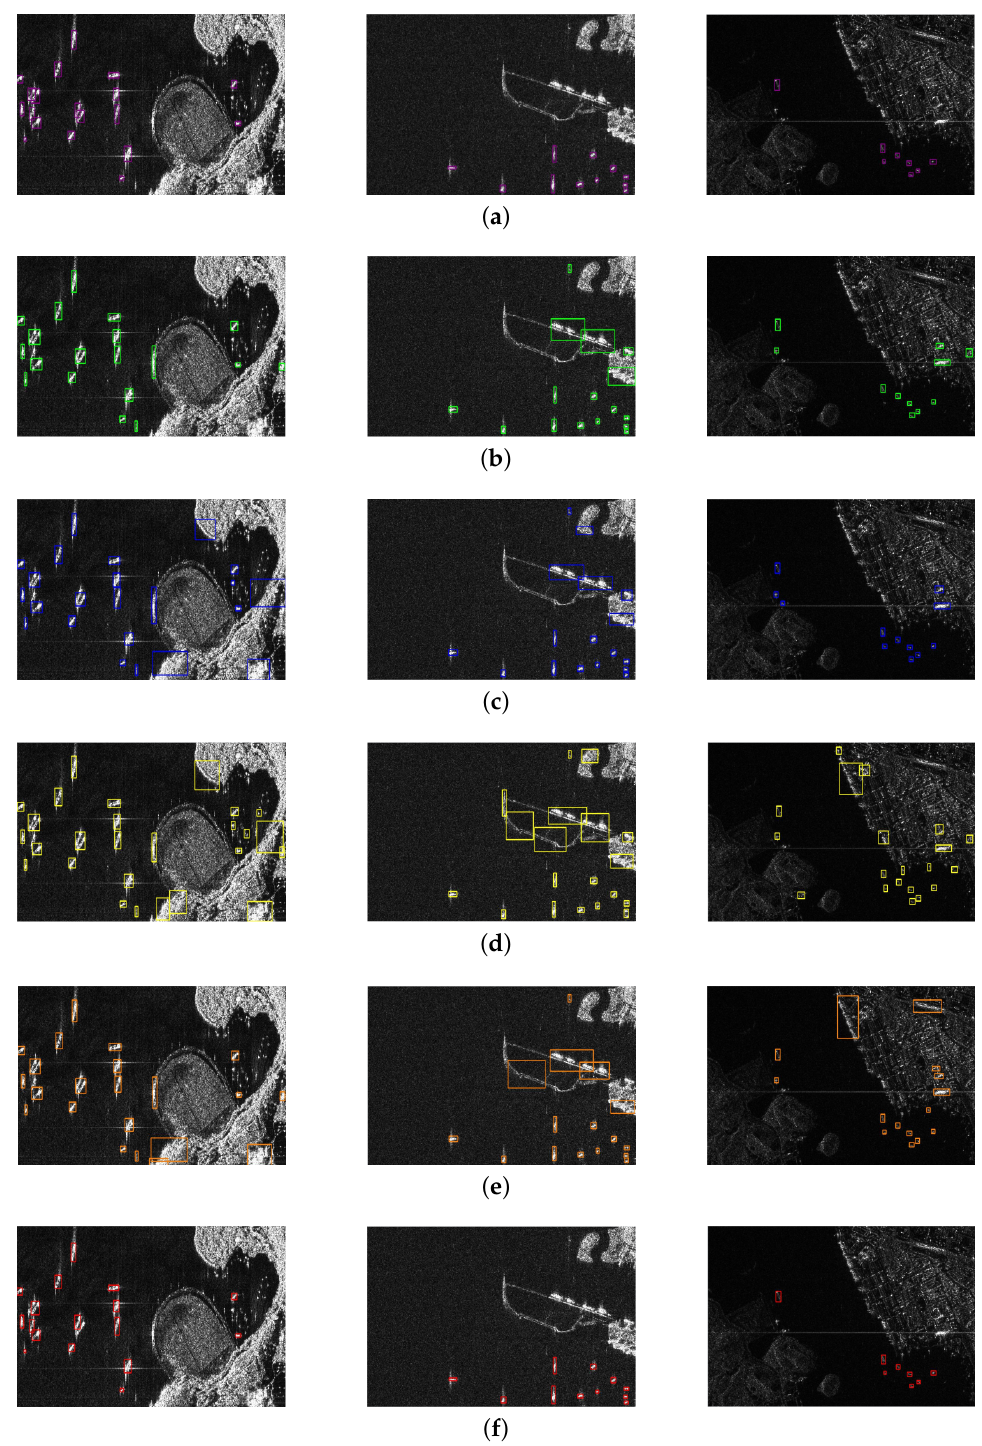
Figure 13. Detection results of different methods on inshore images. ( a ) Ground truth; ( b ) Cascade RCNN; ( c ) DCN; ( d ) Guide anchoring; ( e ) PAFPN; ( f )